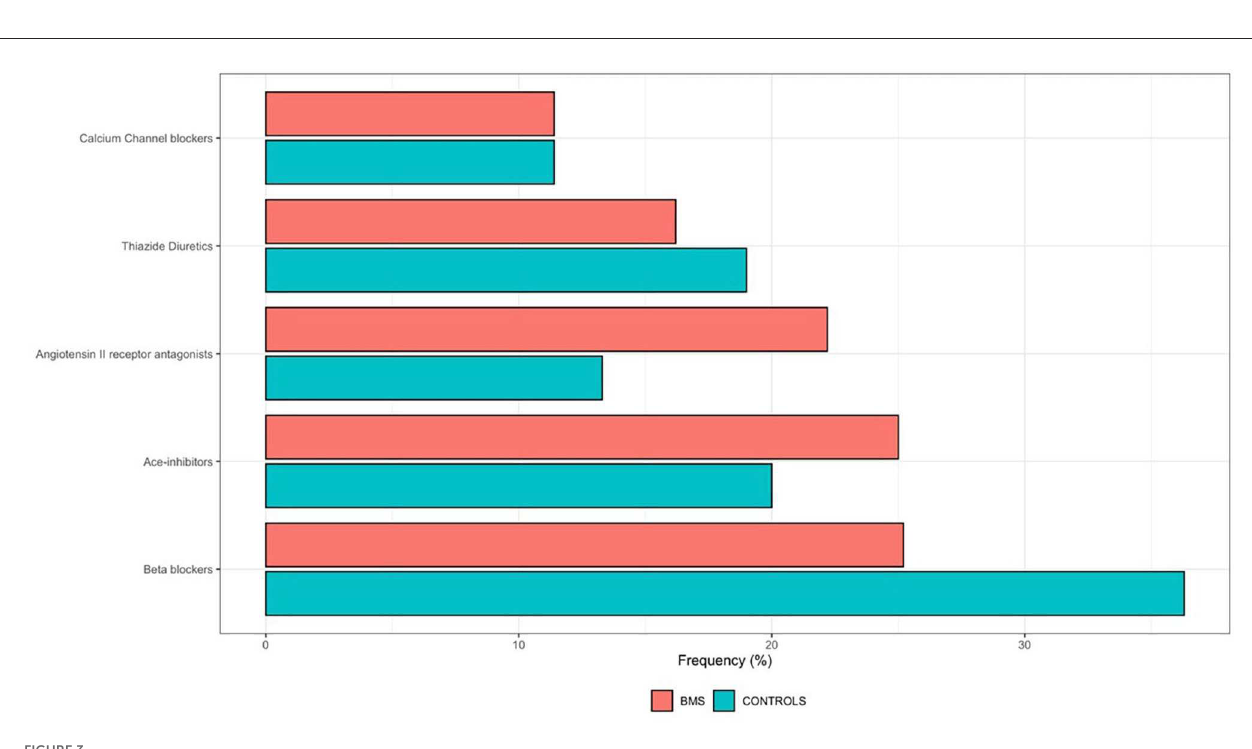
had mild depression (HAM-D: 8–18) and 102 WBMS (40.8%) had moderate depression (HAM-D: 17–23). Severe anxiety (HAM-A: 25– 30) and severe depression (HAM-D > 24) were found in 18 WBMS (7.2%) and in 29 WBMS (11.6%),